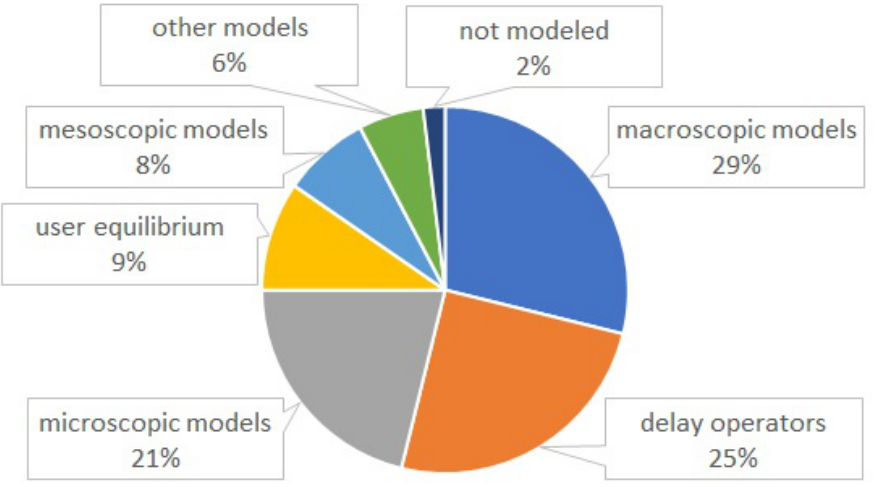
Figure 5. The distribution of the analyzed studies sorted by traffic simulation method.